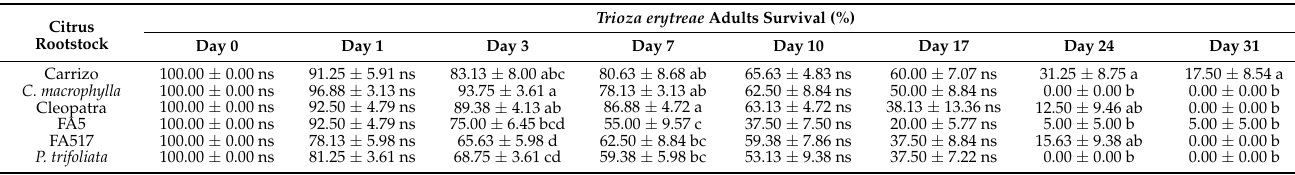
Values with different letters indicate statistical differences among the rootstocks per assessment period by LSD-Fisher test ( p < 0.05). ns: no significant differences. Day: Assessment day; Carrizo: Carrizo citrange; C. macrophylla : Citrus macrophylla ; Cleopatra: ‘Cleopatra’ mandarin; FA5: Forner-Alcaide no. 5; FA517: Forner-Alcaide no. 517; P. trifoliata : Poncirus trifoliata (‘Flying